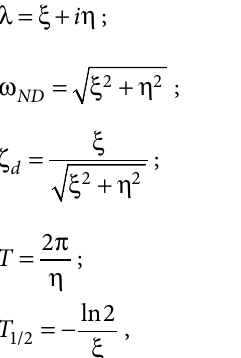
Fig. 7. The static stability margin for configuration No. 1 (on the top) and configuration No. 2 (on the bottom) The second part of the static stability analysis is the directional static stability. The derivative of the yawing moment with respect to the sideslip angle is presented in Figure 8. The MAS is directionally statically stable for both configurations of the MAS.